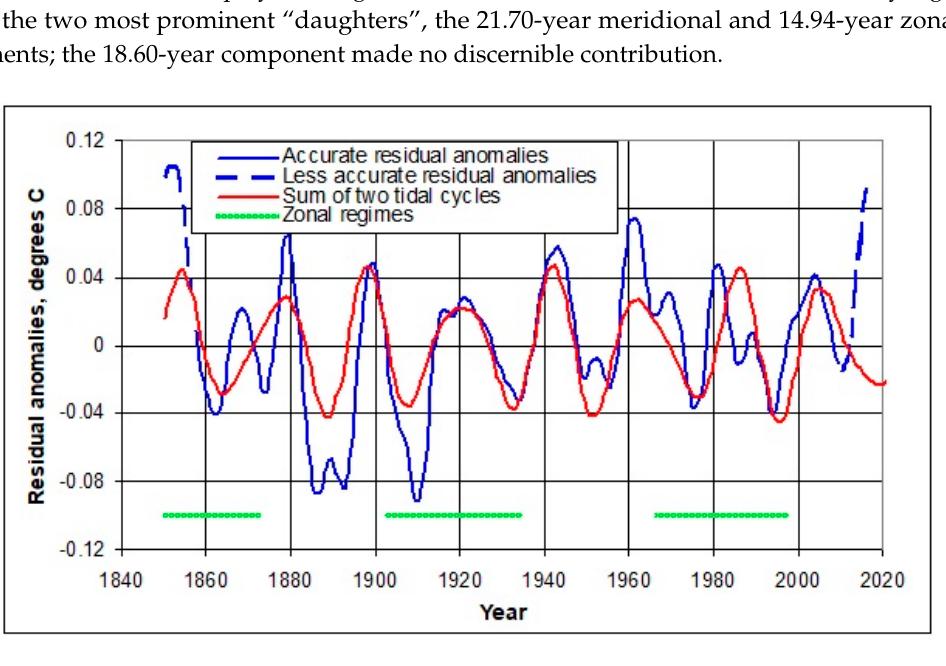
Figure 5. Residual HadCRUT4 decadally smoothed anomalies after removing a ~60-year oscillation and an exponential rise in temperature, compared with a sum of 21.70- and 14.94-year tidal anomalies prone to “end effects” in the smoothing process are labeled “less